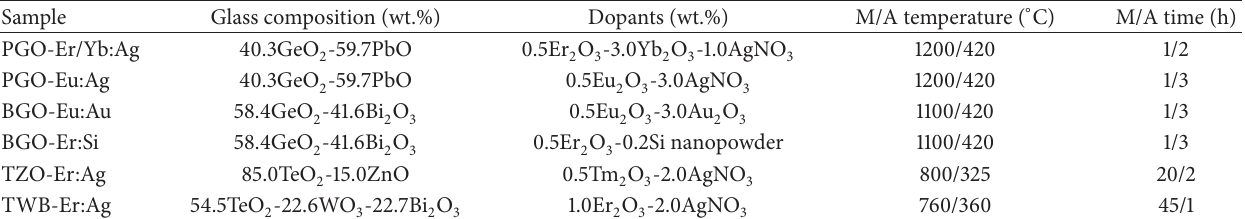
Table 1: Composition and parameters used for production of the glass samples. M/A refer to melting/annealing. Sample Glass composition